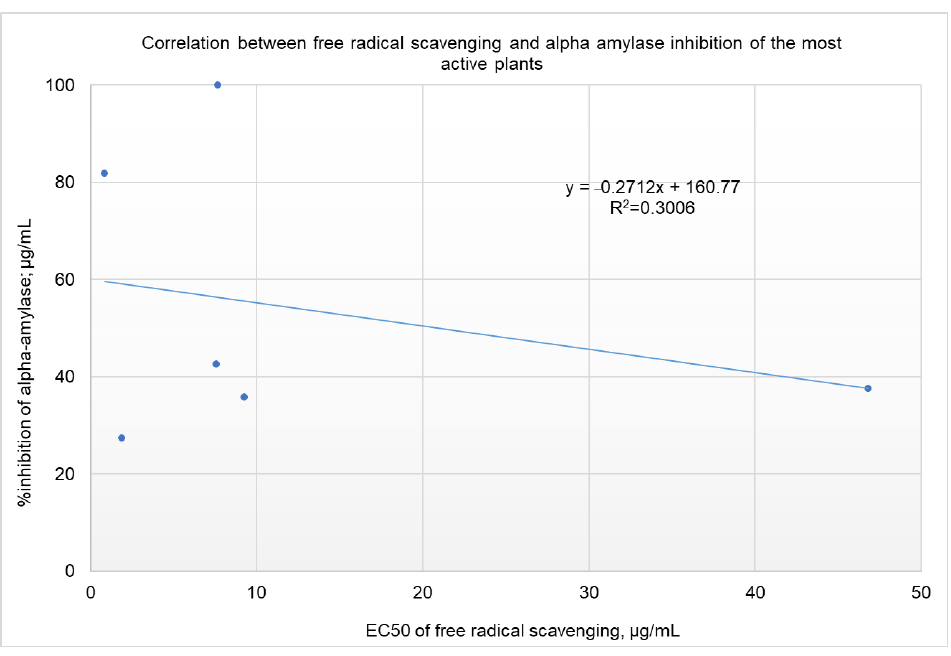
Figure 3. Correlation between the percentage of inhibition of α-amylase and the EC 50 for FRSA for the six most active plant extracts.